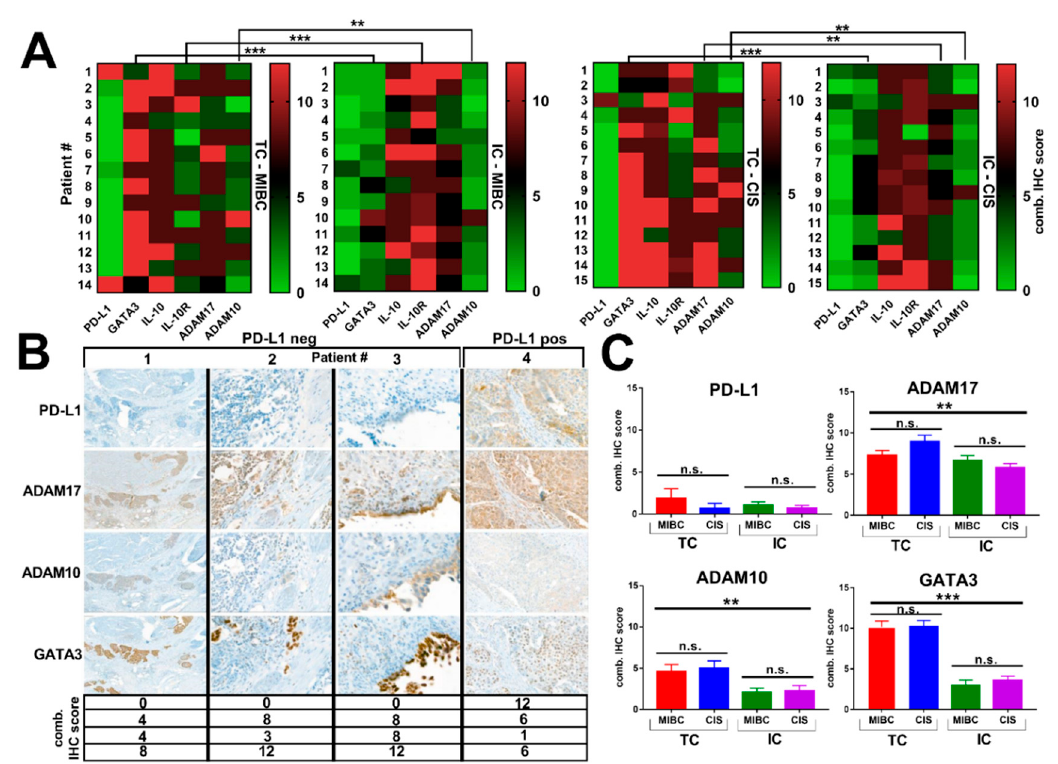
Figure 3. ( A ) Heat mapping with continuous green-black-red shading. Heat maps from individual patients (labeled 1 to 14 or 1 to 15) are arranged from top to bottom left based on increasing IHC combined score (0–12) of PD-L1, GATA3, IL-10, IL-10R, ADAM17, and ADAM10. Barlines show the direct comparison between TC and IC within MIBC and CIS. * p < 0.05; ** p < 0.01; *** p < 0.001 according to Mann–Whitney U test. ( B ) Representative IHC images of PD-L1, ADAM17, ADAM10, and GATA3 within MIBC for four selected patients, presenting three patients with PD-L1 negative status (#1–3, pure urothelial carcinoma, comb. score of 0 in all patients) and one patient (#4) with positive PD-L1 expression (combined score of 12, urothelial carcinoma with squamous differentiation). Final histology at RC specimens confirmed pT3b + CIS N0R0 (patient #1), pT3a N2R0 (patient #2), pT1 HG + CIS N0R0 (patient #3), and pT3b N1R0 (patient #4). Irrespective of PD-L1 status, patients display GATA3 and simultaneous ADAM17 expression. ( C ) Mean IHC combined scores for PD-L1, ADAM17, ADAM10, and GATA3 assessed for both tumor regions (MIBC and CIS) and both cell types (TC and IC) are shown. Statistically significant differences of expression patterns were confirmed for GATA3, ADAM17, and ADAM10. Data represent mean ± SEM (* p < 0.05; ** p < 0.01; *** p < 0.001 according to independent samples Kruskal–Wallis test and Mann–Whitney U test).